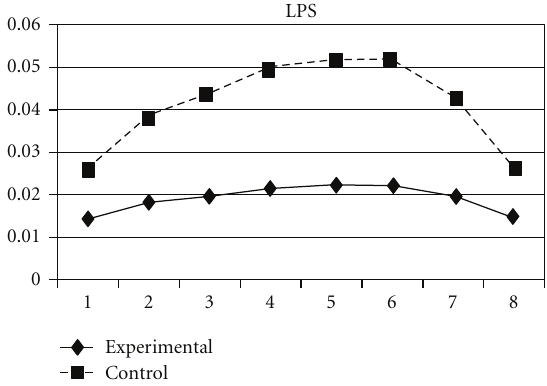
Figure 10: Growth trajectories of the experimental group (all par- ticipants) and control group using the item score of cannabis use as the outcome indicator.